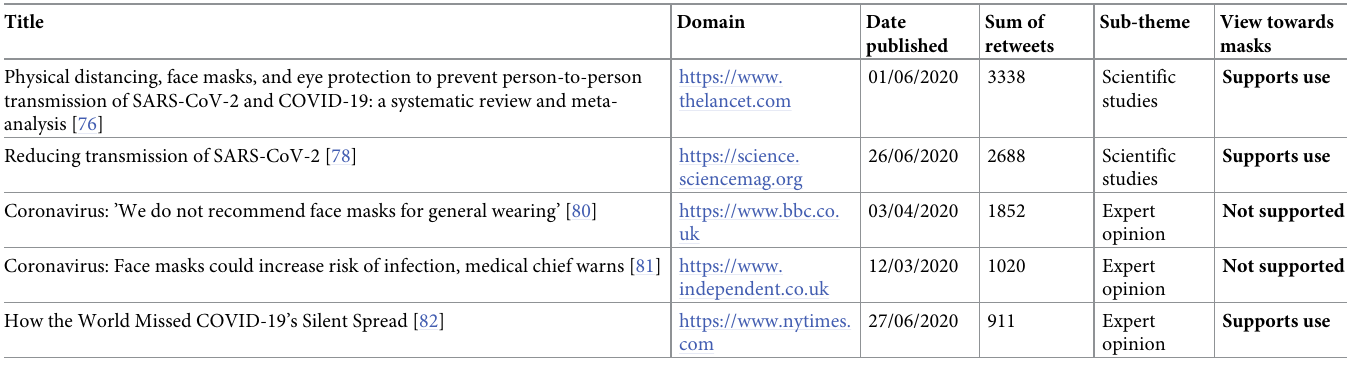
Table 6. Most retweeted URL titles (duplicates combined) for URLs classified as ‘scientific evidence and expertise’ in ‘most retweeted tweets’